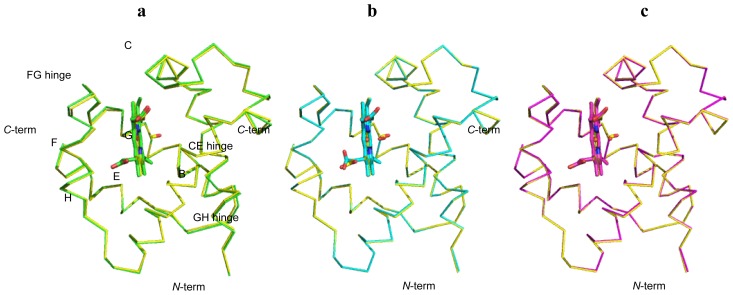
(a) Superimposition of unligated-CerHb (green) on CerHb-CO (yellow). All helical regions are labeled according to the globin fold topology, (b) Superimposition of CerHb-O2 (cyan) on CerHb-CO (yellow), and (c) CerHb-H2O (magenta) on CerHb-CO (yellow).